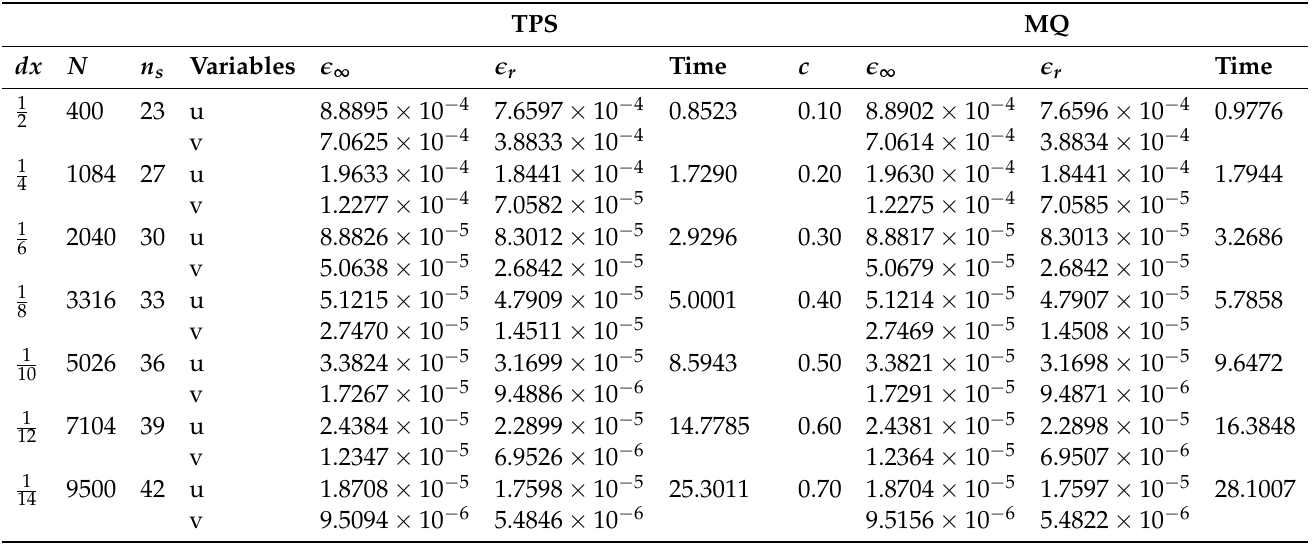
, stencil size n s = 33, and c = 0.35 for different 7